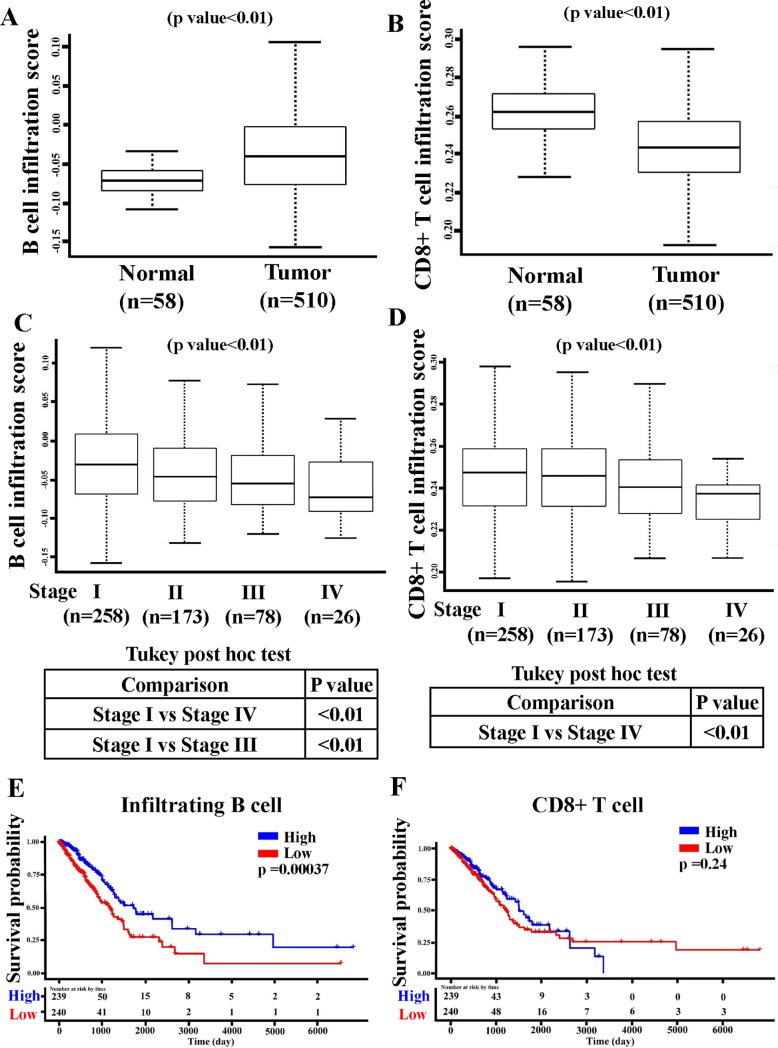
High B-cell infiltration was found in lung adenocarcinoma (LUAD) and was significantly related to patient survival rates.B cell (A) and T cell (B) infiltration scores of LUAD patients (n = 510) and normal group (n = 58) were compared, with the statistical difference calculated using the Wilcoxon rank sum test. B cell (C) and T cell (D) infiltration scores in four different LUAD stages were compared, with the statistical difference calculated using Kruskal–Wallis one-way analysis with Tukey’s post-hoc test. Kaplan–Meier survival curves in LUAD patients with B cell (E) and T cell (F) infiltration scores were analyzed. LUAD patients were divided into two groups based on the median cutoff points for B- and T-cell infiltration scores. The survival rate was measured using a log-rank test.